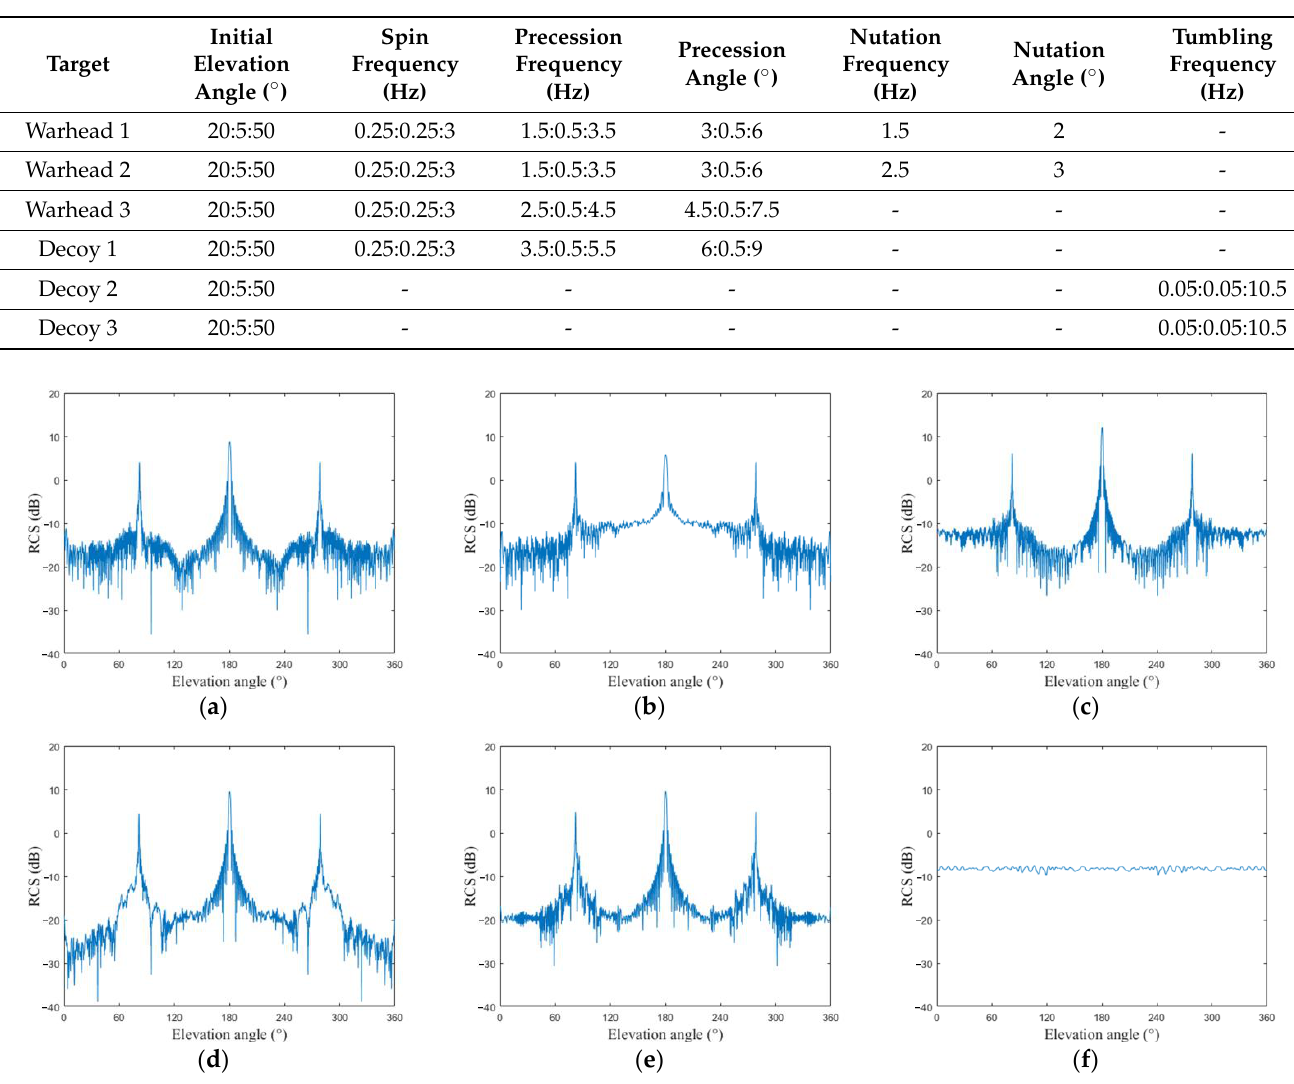
Table 1. Setting of the micro-motion parameters.